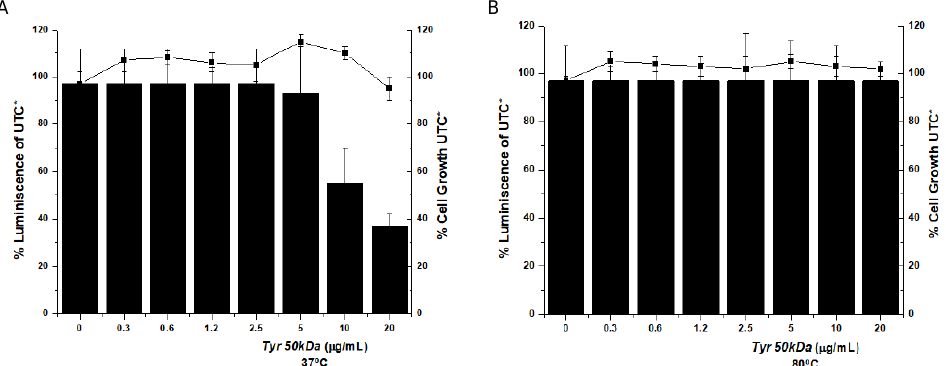
Figure 7. Inhibition of the hepatitis C virus (HCV) replicon in cell assays. Evaluation of the potency and cytotoxicity of temperature-inactivated Tyr50 kDa in cell (Huh-5-2) assays for ( A ) partially inactivated at 37 ◦ C and ( B ) completely inactivated at 80 ◦ C Tyr50 kDa. HCV replicon replication rate (luminescence, black bars) and cell survival (closed squares) were independently measured in cell culture by increasing protein concentration to determine EC50. * All luminescence and viability values were normalized considering the untreated control values (UTC).